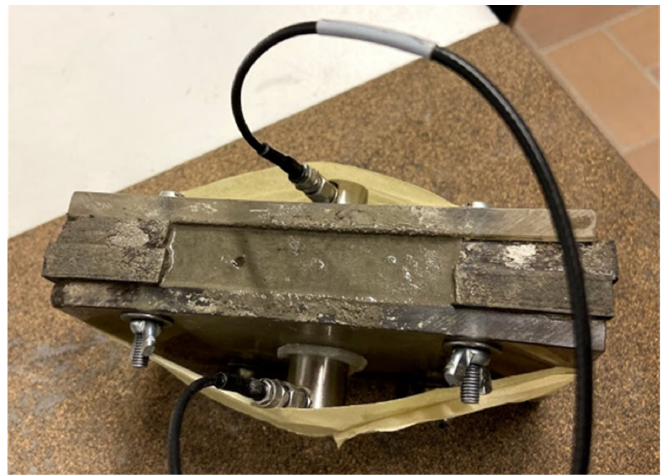
Figure 2. Ultrasound set-up showing the mortar sample in between both